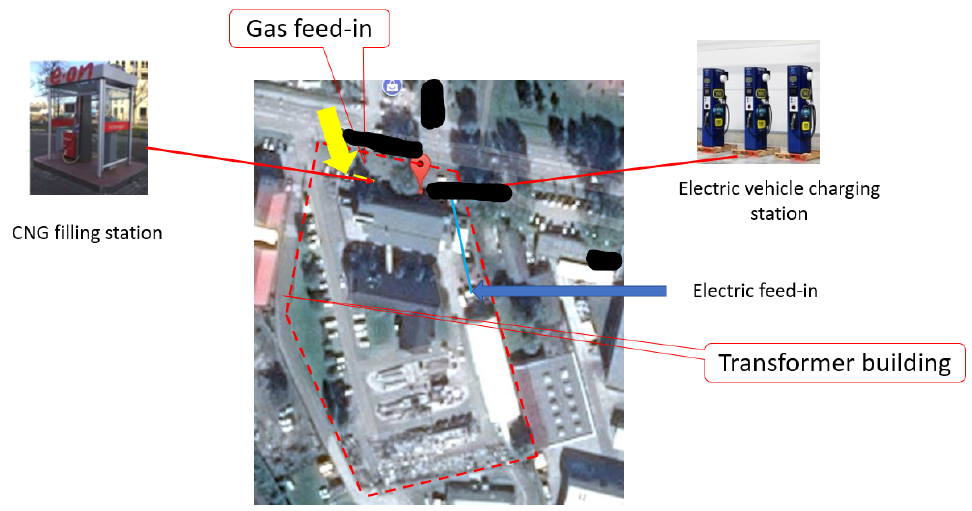
Figure 2. Suggested locations for filling stations.